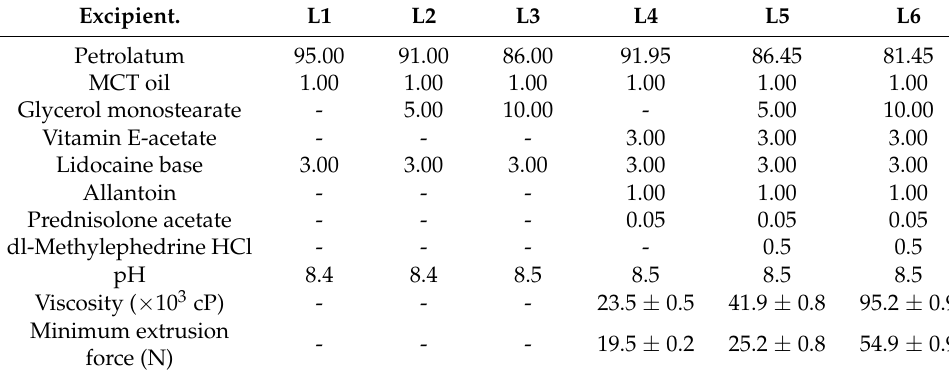
Table 1. Formulation and rheological characterization of lidocaine ointments.